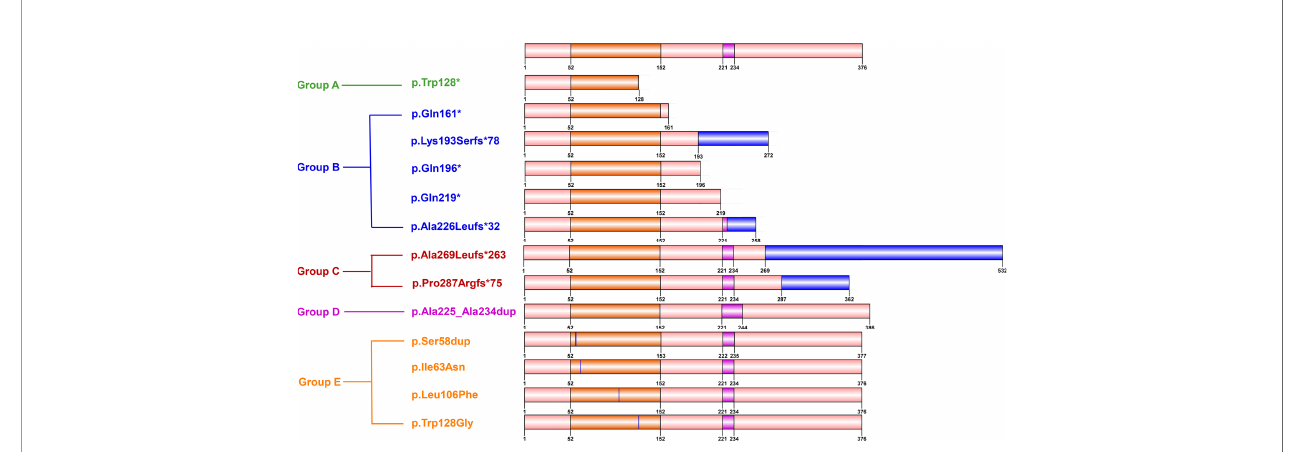
FIGURE 2 | Diagram showing fi ve groups with different types of FOXL2 mutations. Groups A to C: truncated proteins, with partial forkhead domain ( Group A ) , with complete forkhead and without complete polyalanine tract ( Group B ) , and with complete forkhead and polyalanine domain ( Group C ) . Group D: duplication mutations leading to elongated polyalanine tract, group E: missense and single amino acid insertion mutations in forkhead domain.